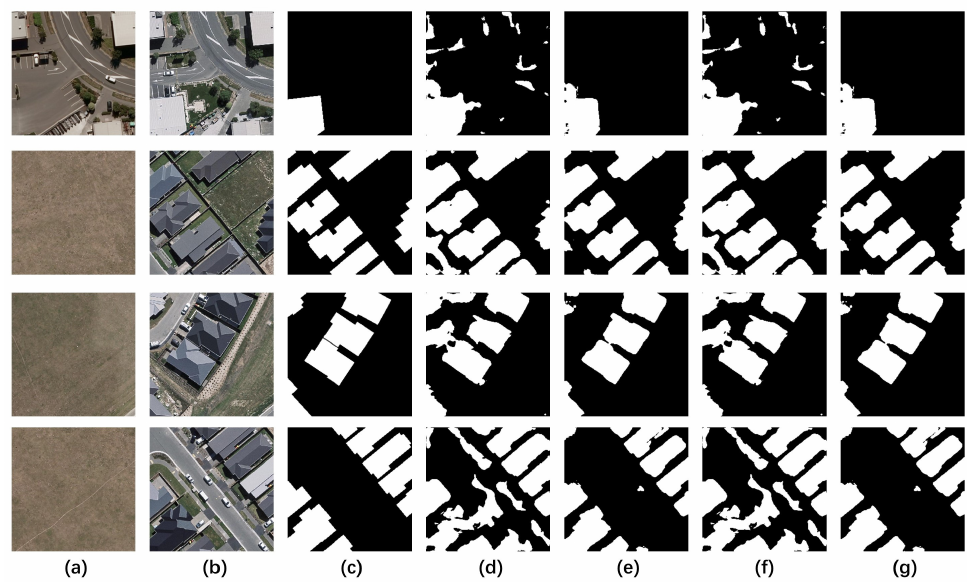
Figure 9. Visual comparison of SANet and semiSANet methods for CD maps for the WHU dataset. ( a ) Image T 1 . ( b ) Image T 2 . ( c ) Ground truth. ( d ) SANet with 50 labeled images. ( e ) semiSANet with 50 labeled images. ( f ) SANet with 100 labeled images. ( g ) semiSANet with 100 labeled